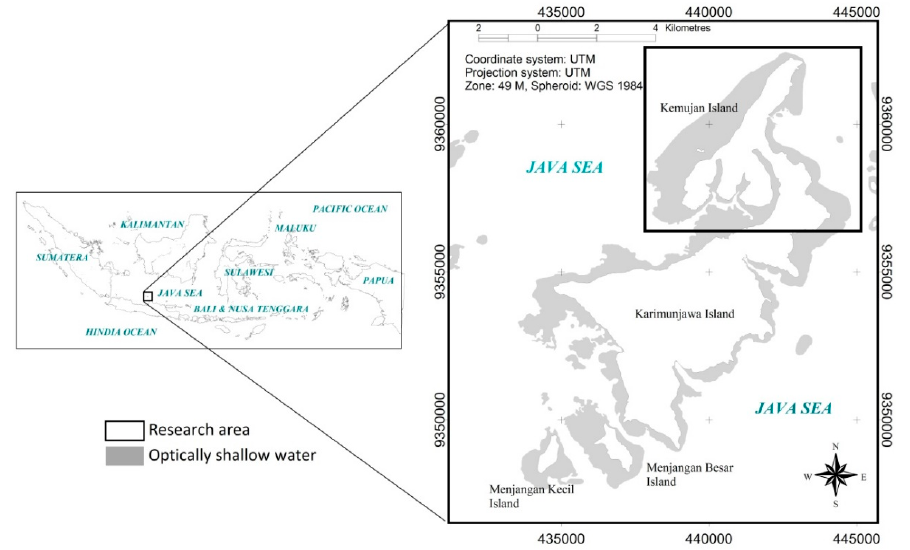
Figure 1. The location of the research area.